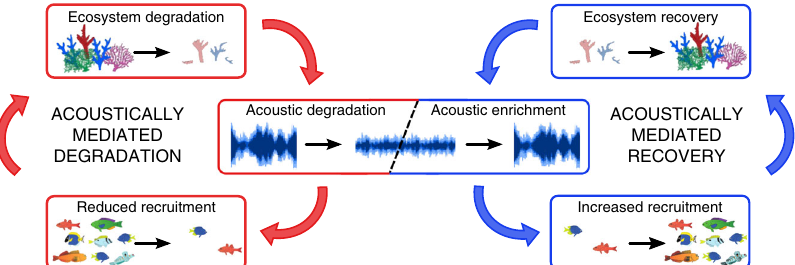
Fig. 4 Schematic illustrating the potential for acoustic enrichment to reverse harmful feedback loops on coral reefs. The left-hand cycle shows acoustically mediated feedback associated with degradation 13 ; the right-hand reverse cycle suggests how acoustic enrichment could facilitate ecosystem recovery through increasing recruitment and enhancing communities of fi shes. Pictures of fi shes are adapted from ref. 12